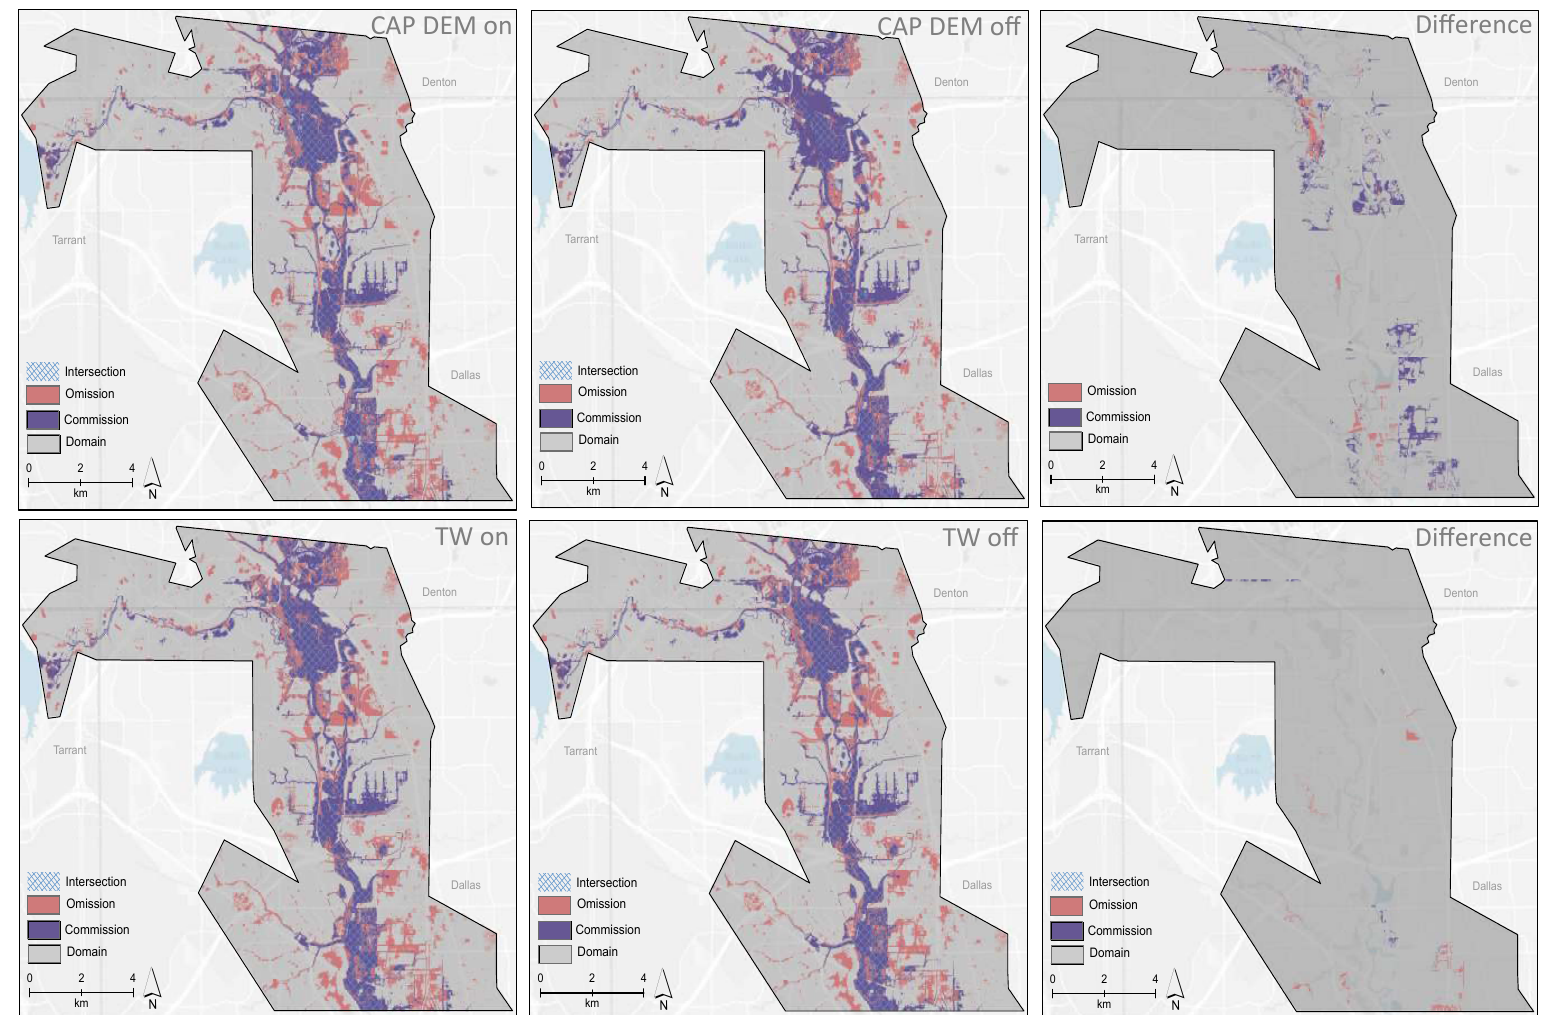
Figure 9. Areas of commission and omission are shown in comparison to the HEC-RAS model output. LS and SPOT observations are displayed on the top row of the figure, and WV, CAP, and TW observations are below. The intersection between the observation data and HEC-RAS is shown with a light blue hashed